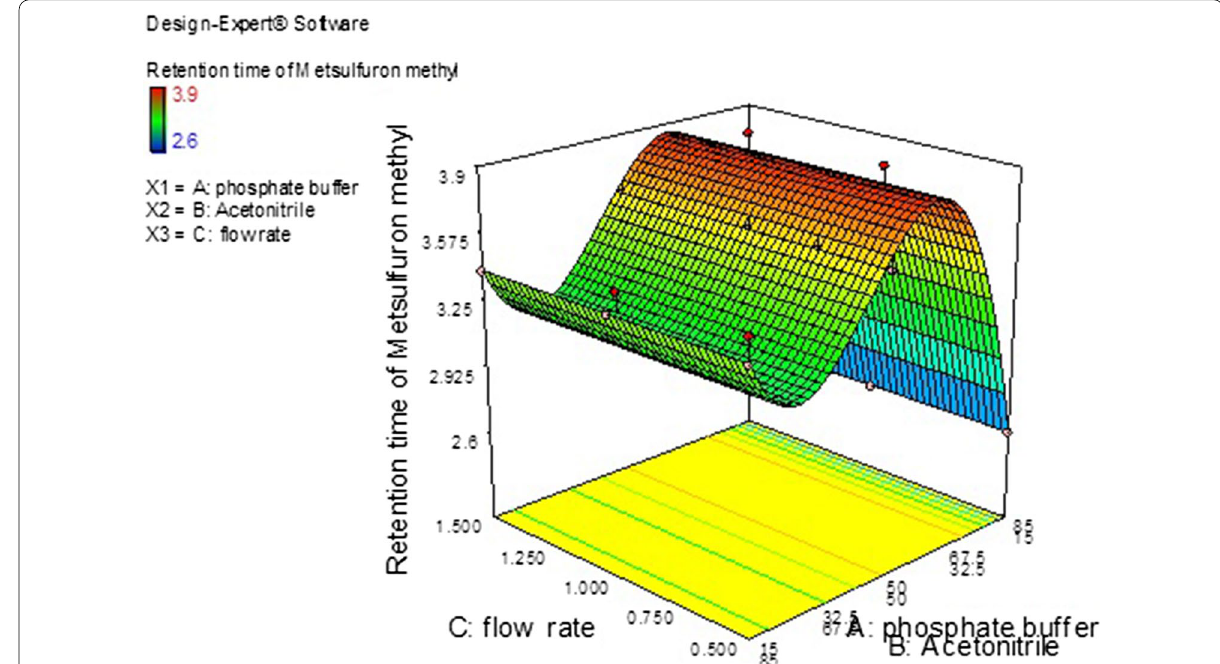
Fig. 2 3D surface plots showing retention time of metsulfuron-methyl as response